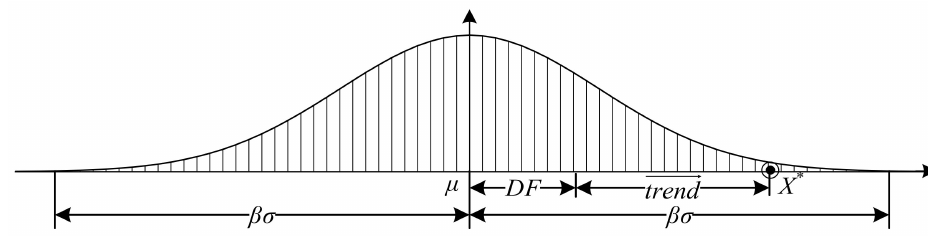
Figure 1. Distribution of jellyfish in the